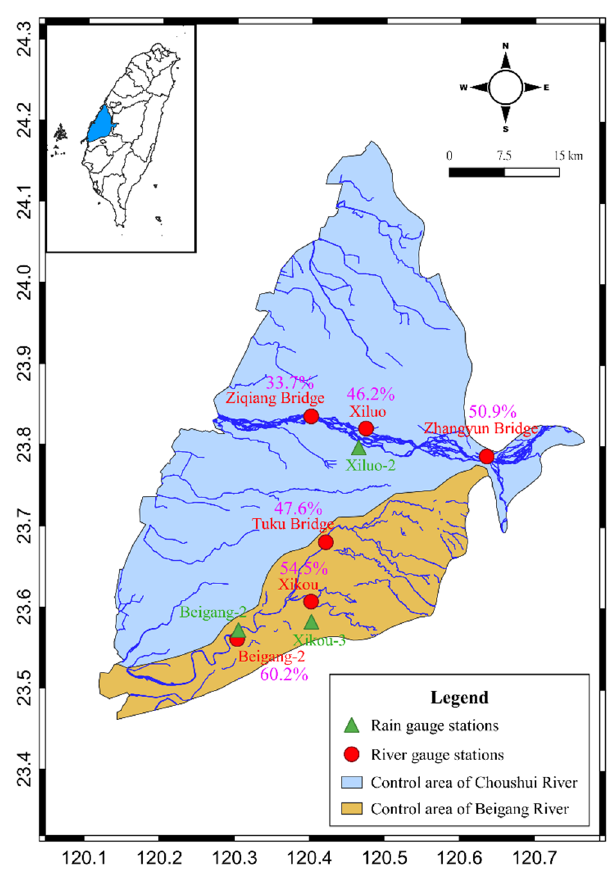
Figure 5. Distribution of river gauge stations and watersheds in the Choushui River alluvial fan. The marked values indicate the baseflow index. Table 2. Adopted river gauge stations in the Choushui River alluvial fan. Watershed